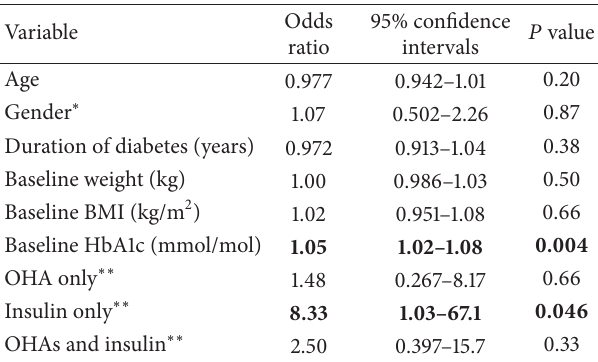
Table 3: Results from the binary logistic regression identifying variables which can predict response to exenatide